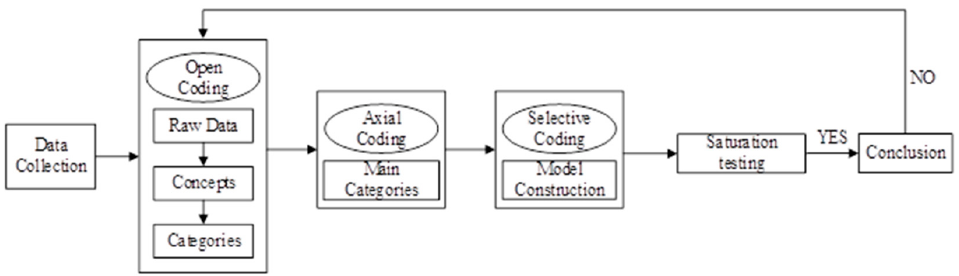
Figure 1. Process of grounded theory.